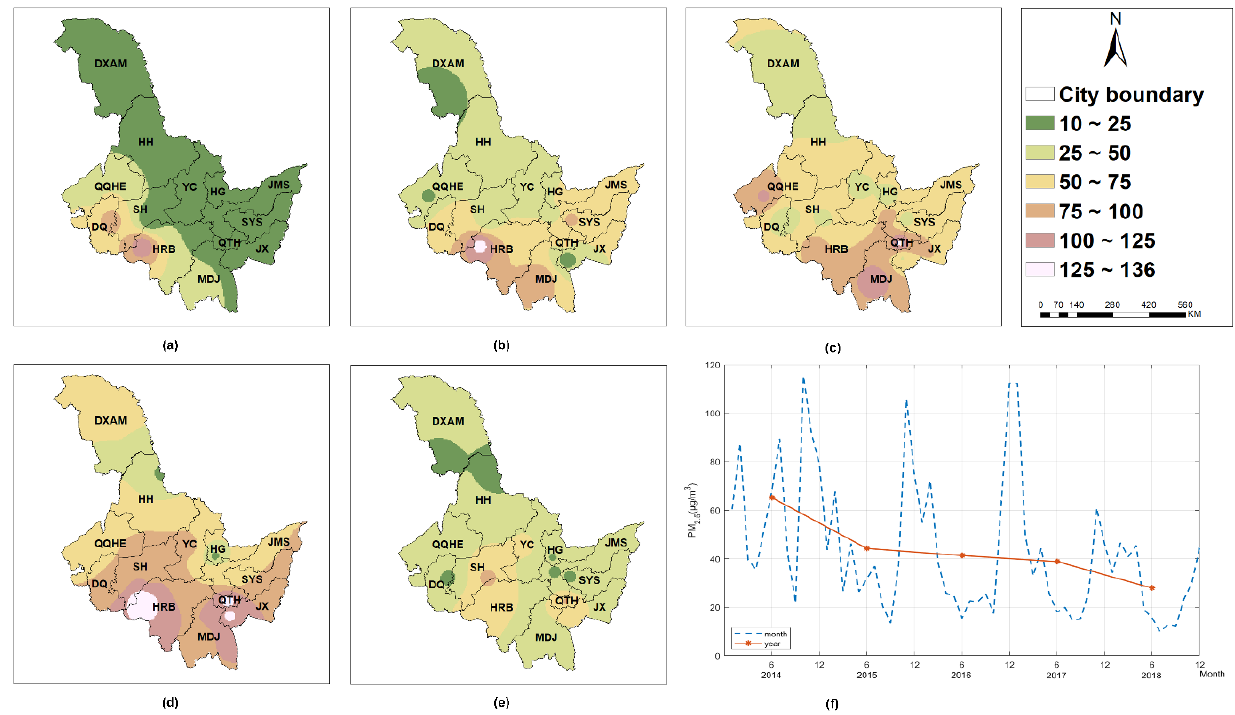
Figure 5. The spatial and temporal distribution of PM 2.5 ( μ g/m 3 ) in Heilongjiang Province from 2014